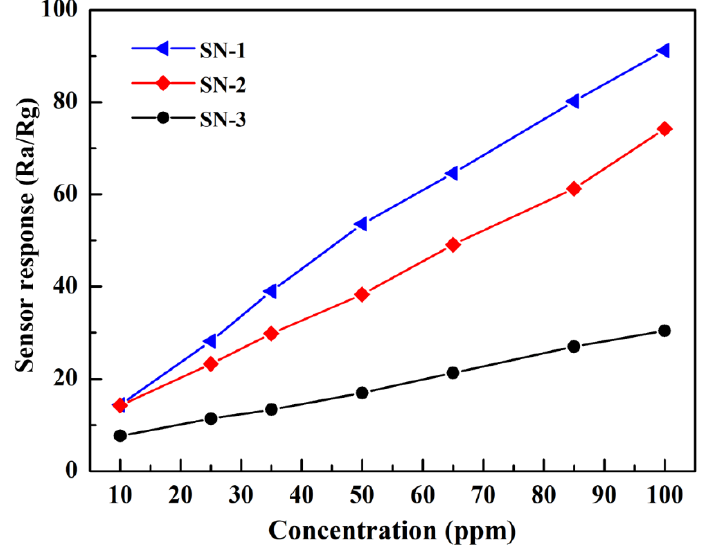
Figure 5. Sensor response curve of three SnO 2 -based gas sensors towards different HCHO concentrations at 275 °C.